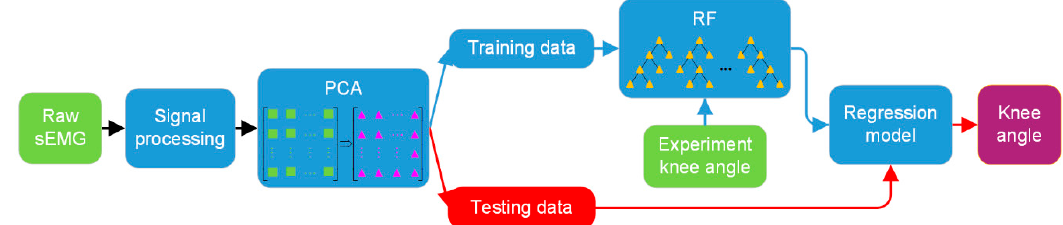
Figure 5. The structural diagram of the random forest with principal component analysis (RFPCA) used for knee estimation from sEMG.